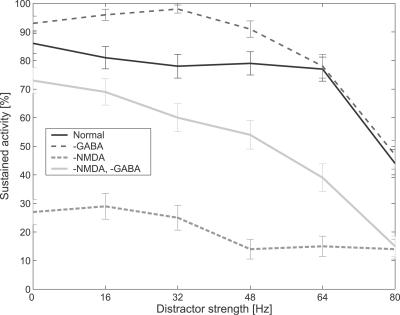
Stability and Distractibility as a Function of the Distractor Strength and the Synaptic EfficaciesWe assessed how often in 100 trials the average activity during the last second (2–3 s) stayed above 10 Hz in the S1 attractor. The modulation of the synapses NMDA: −1 and GABA: −1 corresponds to a reduction of 4.5% and 9%, respectively. The strength of the distractor stimulus applied to S2 is an increase in firing rate above the 2.4-kHz background activity, which is distributed among 800 synapses per neuron. The lower the sustained activity in S1, the higher is the distractibility. The standard deviations were approximated with the binomial distribution.